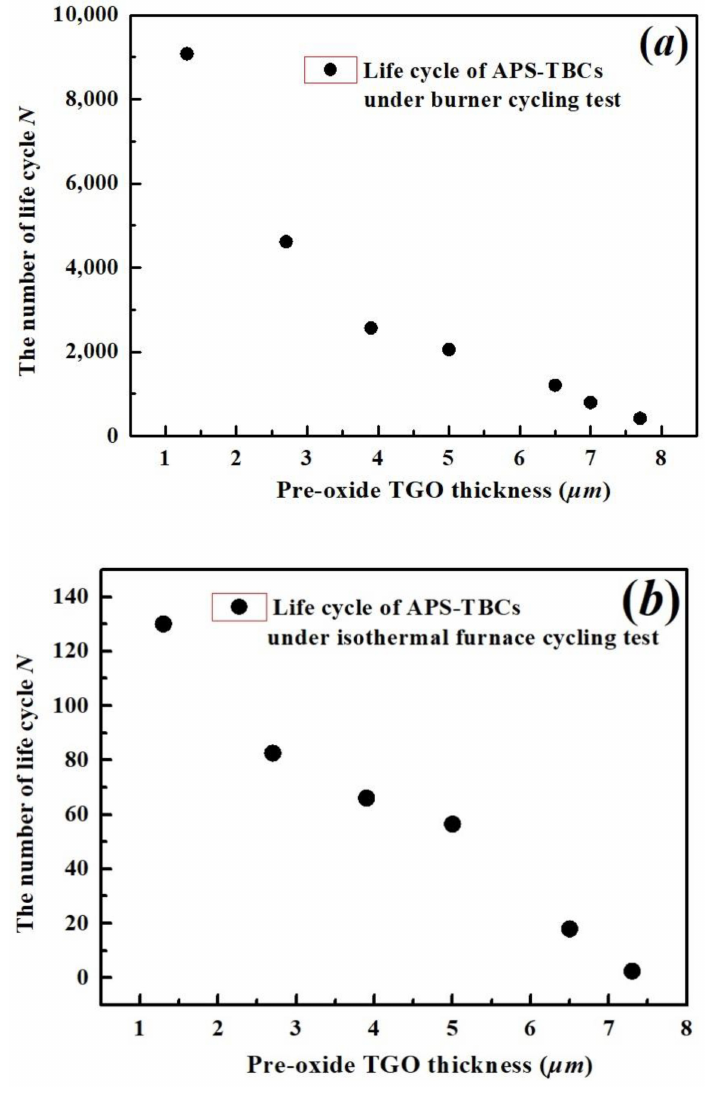
Figure 4. Testing life cycle data of APS-TBCs under ( a ) burner cycling test; ( b ) isothermal furnace cycling test with respect to different pre-oxide TGO thicknesses